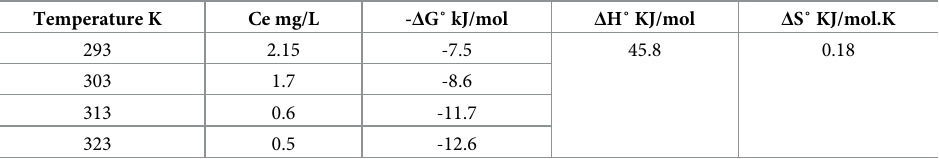
Table 10. Thermodynamic parameters for CIP adsorption.